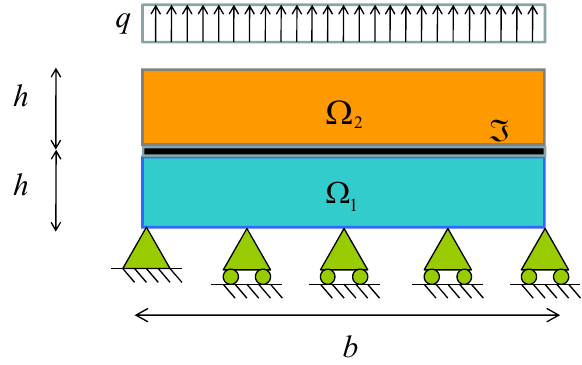
Figure 2: Scheme of the uniaxial